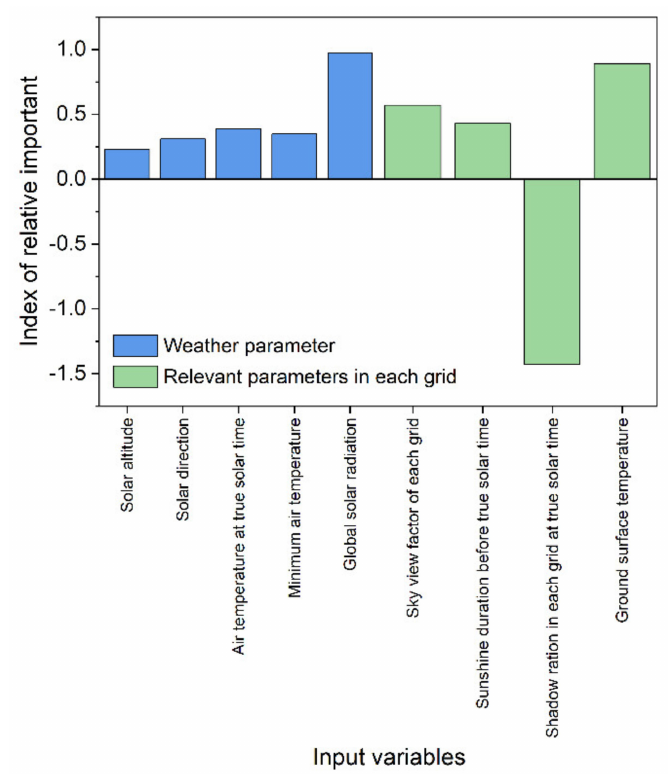
Figure 9. Order of importance of the input variables for hot summer